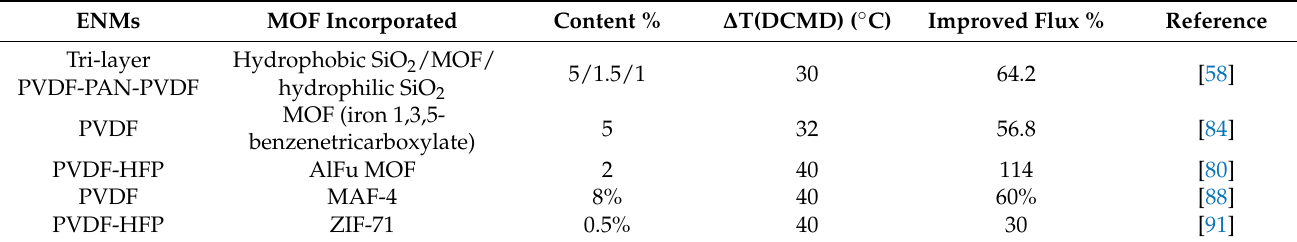
Table 2. ENMs incorporated with